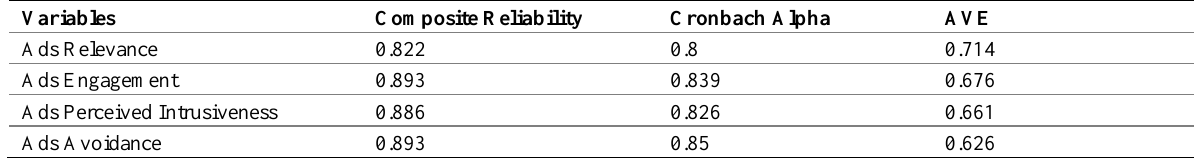
Table 1: Composite Reliability, Cronbach Alpha, AVE